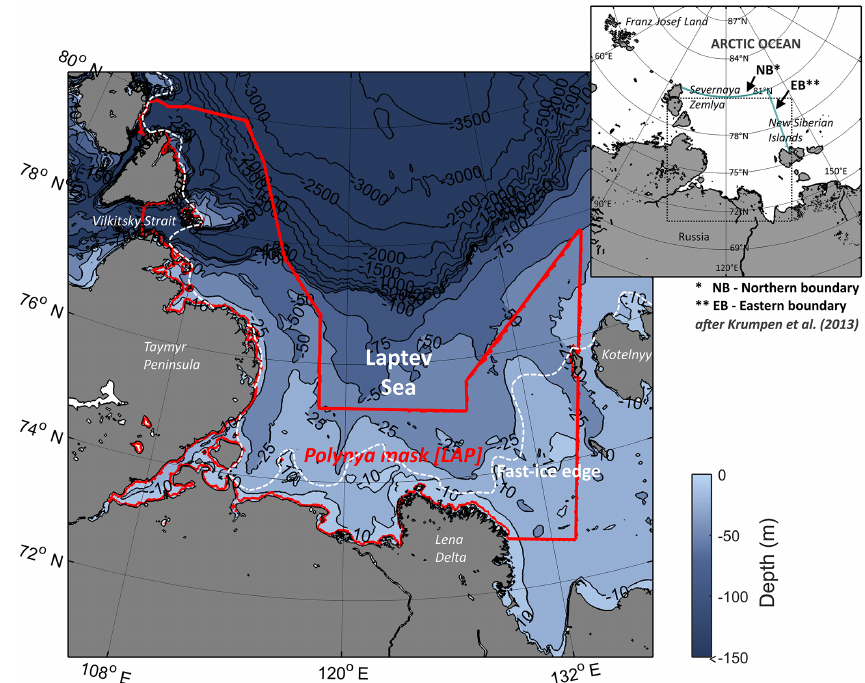
Figure 9. The geographical location of the Laptev Sea in the eastern Arctic. The applied polynya mask is marked in red, enclosing the loca- tions of typical polynya formation along the coast and fast-ice edge (dashed white line; position derived from long-term thin-ice frequencies in March; Fig. 4). Flux gates from the study by Krumpen et al. (2013) at the northern (NB) and eastern (EB) boundary of the Laptev Sea are shown in the inset map (cyan solid lines). Bathymetric data from Jakobsson et al. (2012) (IBCAO